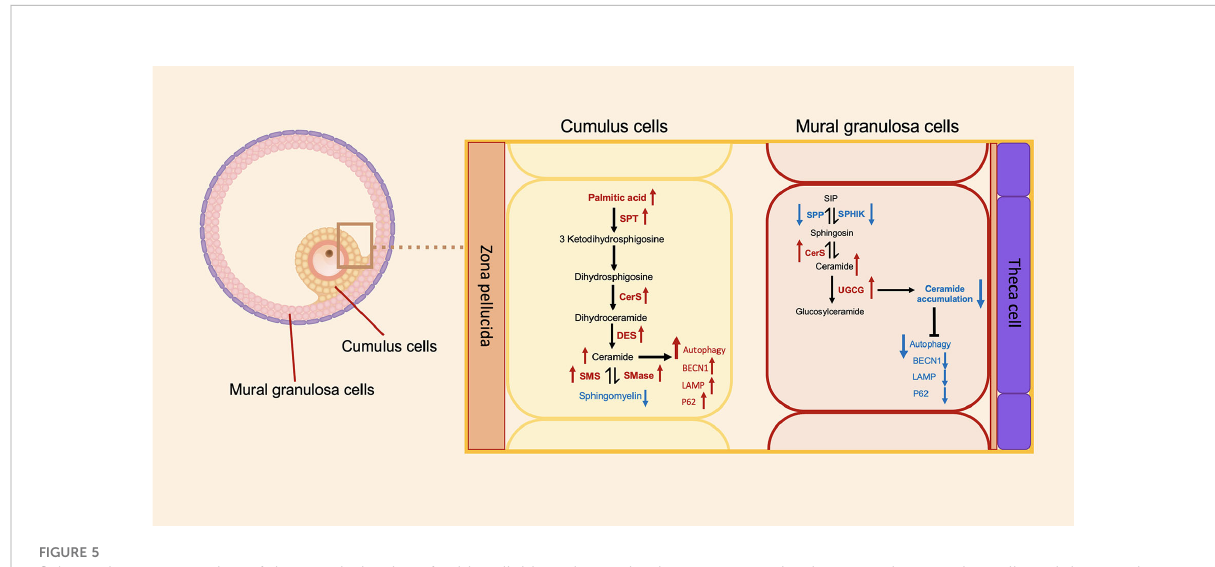
FIGURE 5 Schematic representation of the metabolomics of sphingolipids and autophagic gene expression between the cumulus cells and the mural granulosa cells. Direction of arrows represents the direction of possible activity of sphingolipid pathways. Red colors of arrows represent increased level of metabolite or gene, and blue colors of arrows represent decreased level of metabolite or gene. SPT, serine palmitoyltransferase; CerS, ceramide synthase; DES, dihydroceramide desaturase; SMS, sphingomyelin synthase; SMase, sphingomyelinase; SPP, sphingosine-1-phosphate phosphatase; SPHIK, sphingosine kinase; UGCG, UDP-glucose ceramide glucosyltransferase; BECN1, Beclin1; LAMP, lysosome-associated membrane